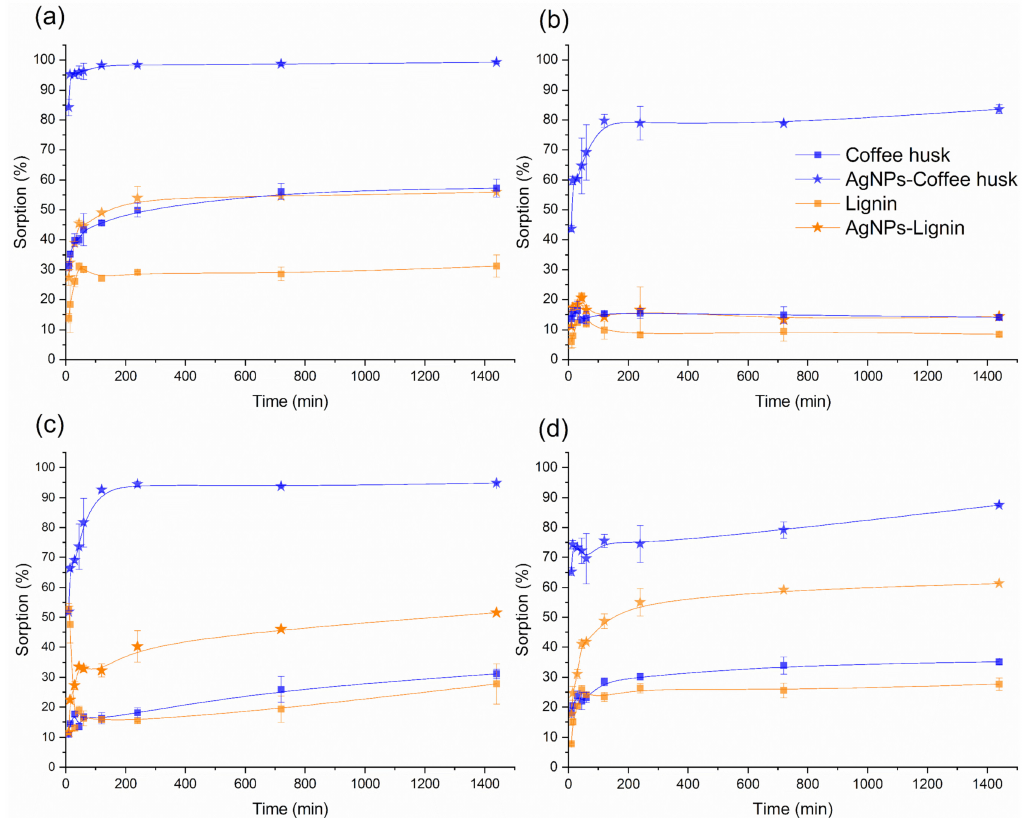
Figure 3. Sorption kinetics for ( a ) lead, ( b ) cadmium, ( c ) chromium, and ( d )